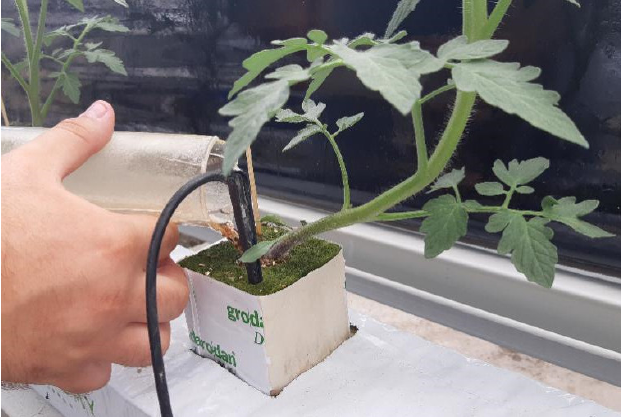
Figure A1. Tomato plants with ripe fruits at 97 DAT.